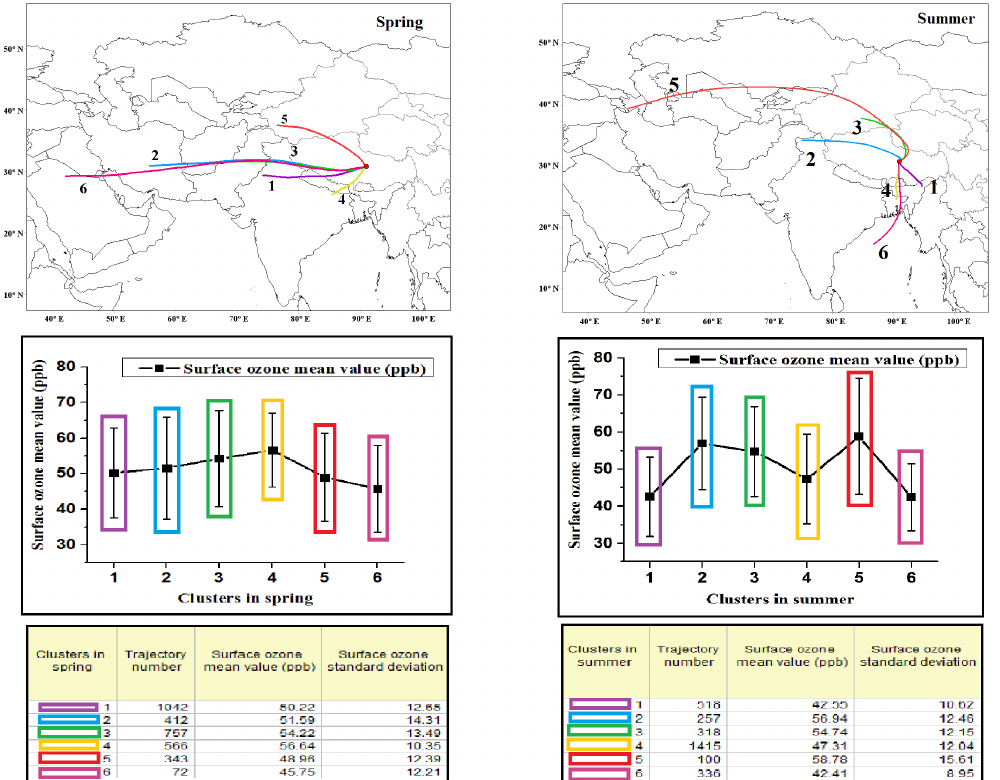
Figure 11. Mean trajectory of six HYSPLIT clusters arriving at Nam Co Station in the spring and the summer and the range of surface ozone mixing ratios measured at Nam Co Station by